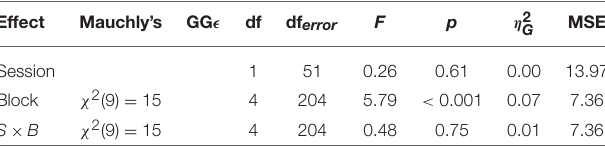
TABLE 1 | Analysis of variance for sugar factory task with trials on target as dependent measure. Effect